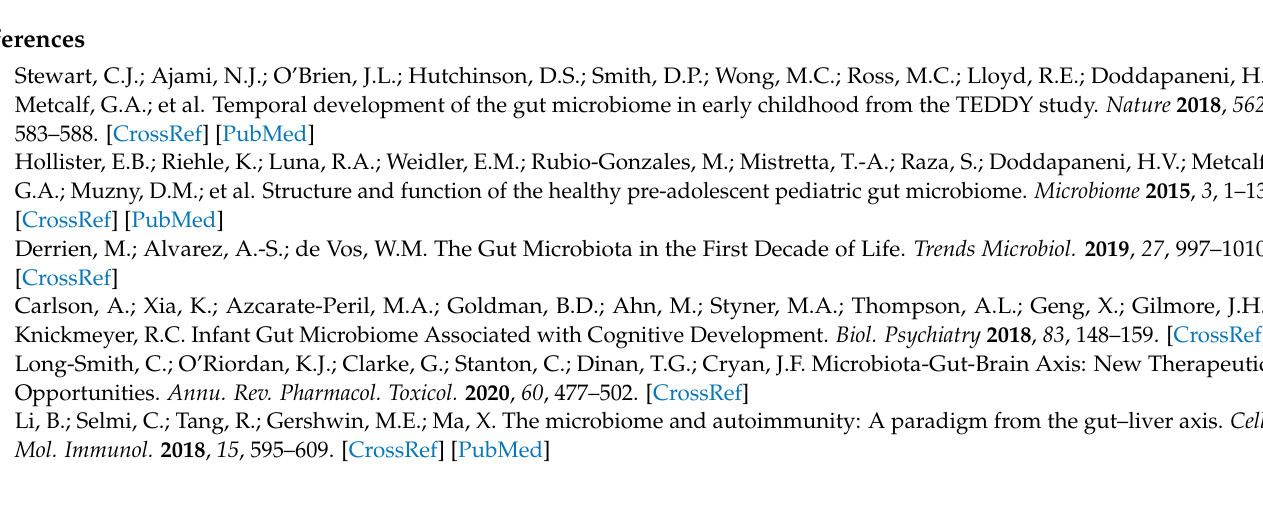
Supplementary Figure S2: Dietary intake in normal weight compared to overweight and obese (combined in the figure as overweight) participants. Children that were overweight/obese consumed ( A ) significantly less carbohydrates compared to their normal weight counterparts ( p = 0.025); ( B ) a relatively similar percentage of calories from protein ( p = 0.275); ( C ) a higher percentage of calories from fat ( p = 0.050); ( D ) saturated fat ( p = 0.105); and ( E ) MUFAs ( p = 0.079). Intake of PUFAs was relatively similar ( p = 0.536). Supplementary Figure S3: ( A ) No significant association between alpha diversity and socioeconomic scores (Observed OTUs p = 0.13). ( B ) A trend of decreased bacterial richness among obese participants compared to their normal weight and overweight counterparts (observed OTUs p = 0.09 for both pairwise comparisons). Supplementary Table S1: Bacterial composition in the whole cohort. Supplementary Table S2: Maaslin2 results for the whole cohort. Supplementary Table S3: Bacterial composition in the low SES group. Supplementary Table S4: Maaslin2 results for the low SES group. Supplementary Table S5: Bacterial composition in the high SES group. Supplementary Table S6: Maaslin2 results for the high SES group. Supplementary Table S7: Maaslin2 results for the participants with